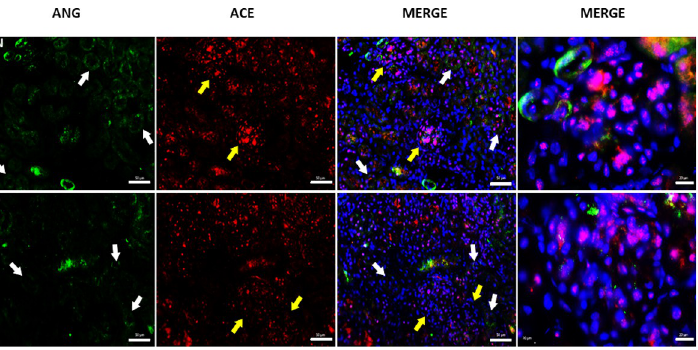
Fig 4. Expression and distribution of angiotensin and ACE in the kidneys of control (CON) and SCD (SCD) mice. Immunofluorescent staining of kidney sections for angiotensin and ACE. Angiotensin (I, II and III) was stained with anti-angiotensin and AlexaFluor 1 488-conjugated secondary antibody (green); ACE was detected with anti-ACE and AlexaFluor 1 555-conjugated secondary antibody (red); nuclei were stained with DAPI (blue). The arrows show tubule (white) and glomerular (yellow) structures. Images are representative of three kidney sections from N = 3 mice. Scale bar = 50 μ m and 20 μ m (Magnified merge).